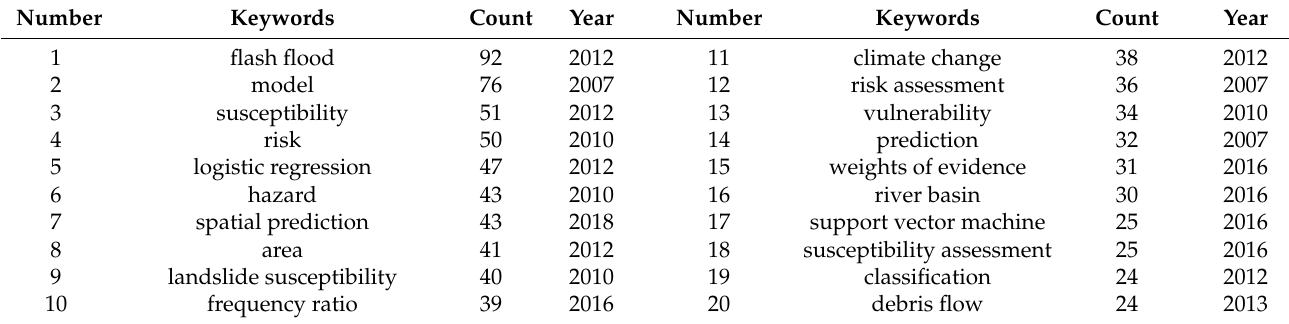
Figure 7. Frequency diagram of keywords. Table 4. Top 20 high-frequency